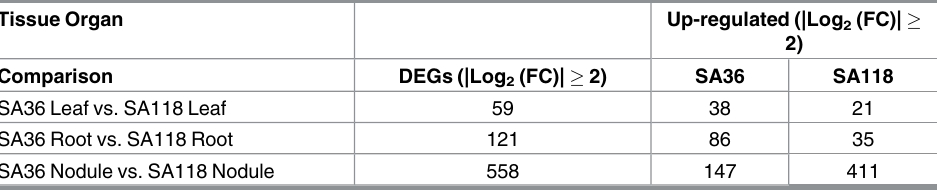
DEGs, differentially expressed genes: |Log 2 (FC)| (cid:21) 2, absolute logarithmic fold change in expression greater or